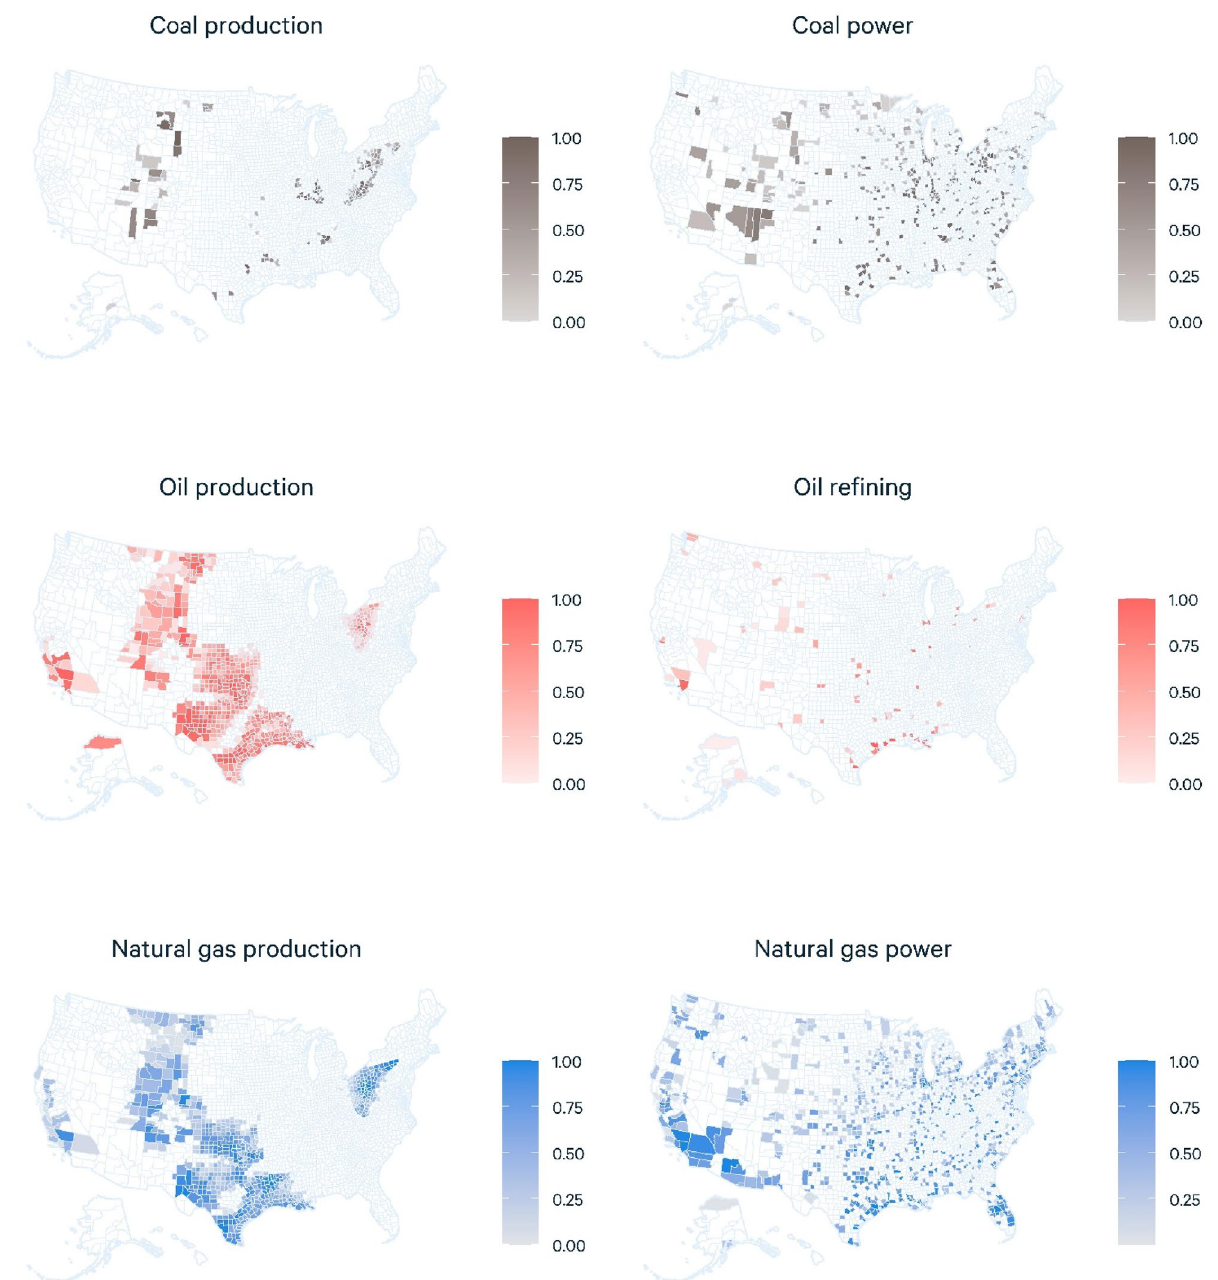
Figure 1. US county-level exposure and sensitivity to energy transition. These maps show results across all activity and fuel types, in which colored shading indicates the percentile of each US county’s exposure and sensitivity to a transition away from fossil fuels. Counties in the highest percentile for the combined measures of exposure and sensitivity are colored darkest, and counties with lower scores are colored more